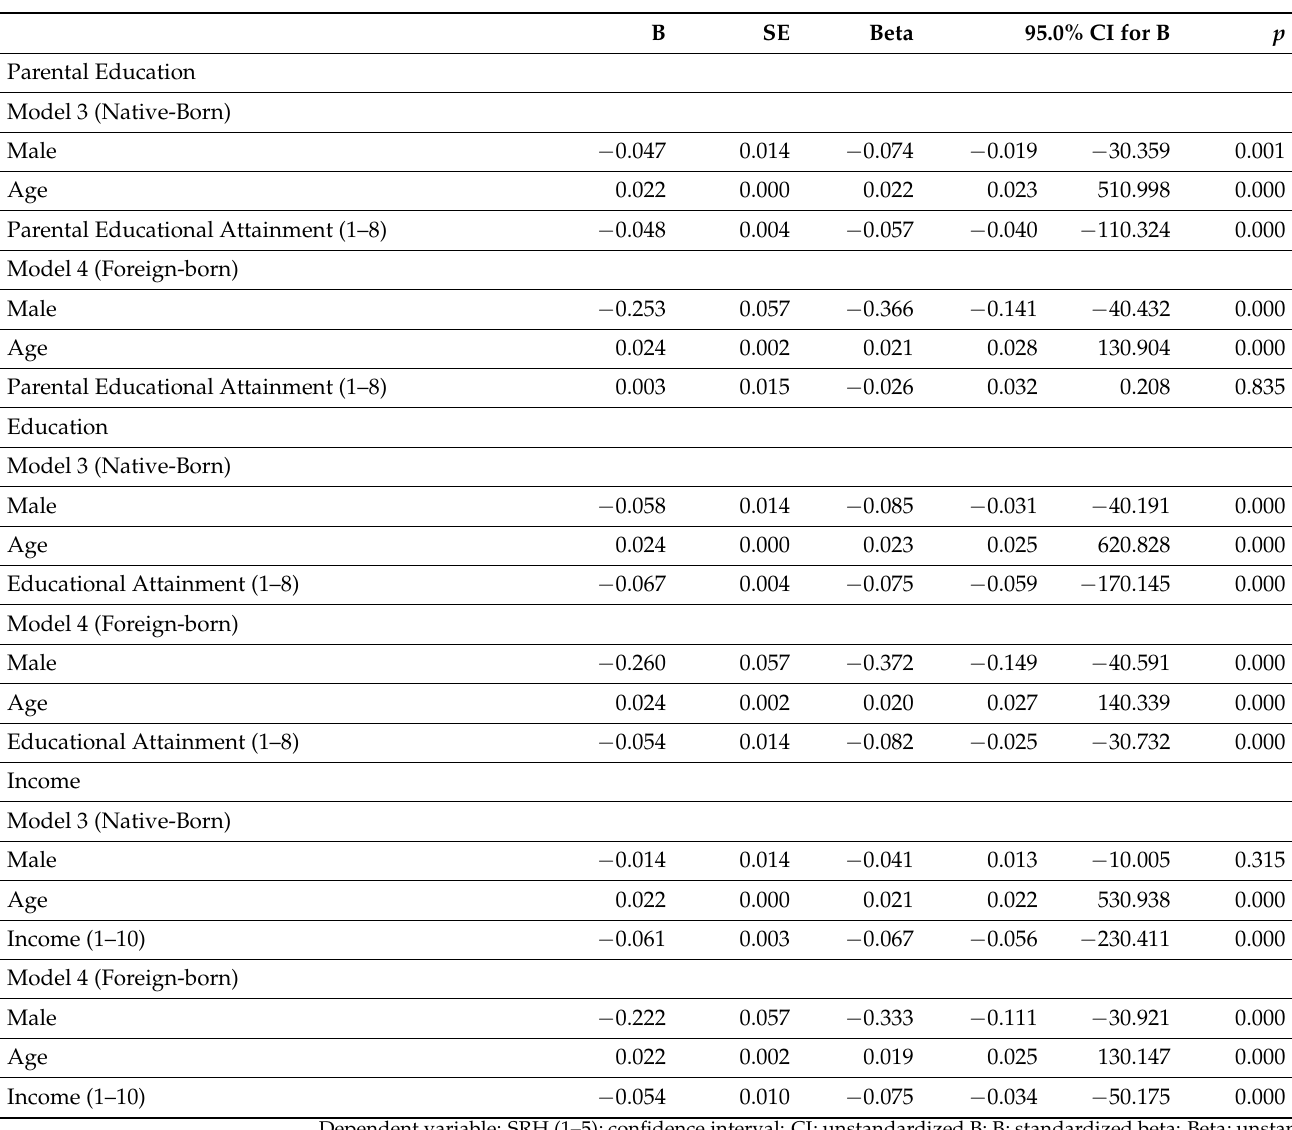
Table 3. Summary of linear regressions in native-born and foreign-born